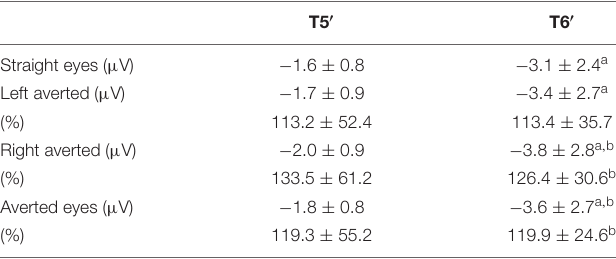
TABLE 1 | Mean and SD of the maximum amplitude of the N190 component at T5 (cid:48) and T6 (cid:48) electrodes for straight eyes, left averted, right averted, and averted eyes (mean value of left averted and right